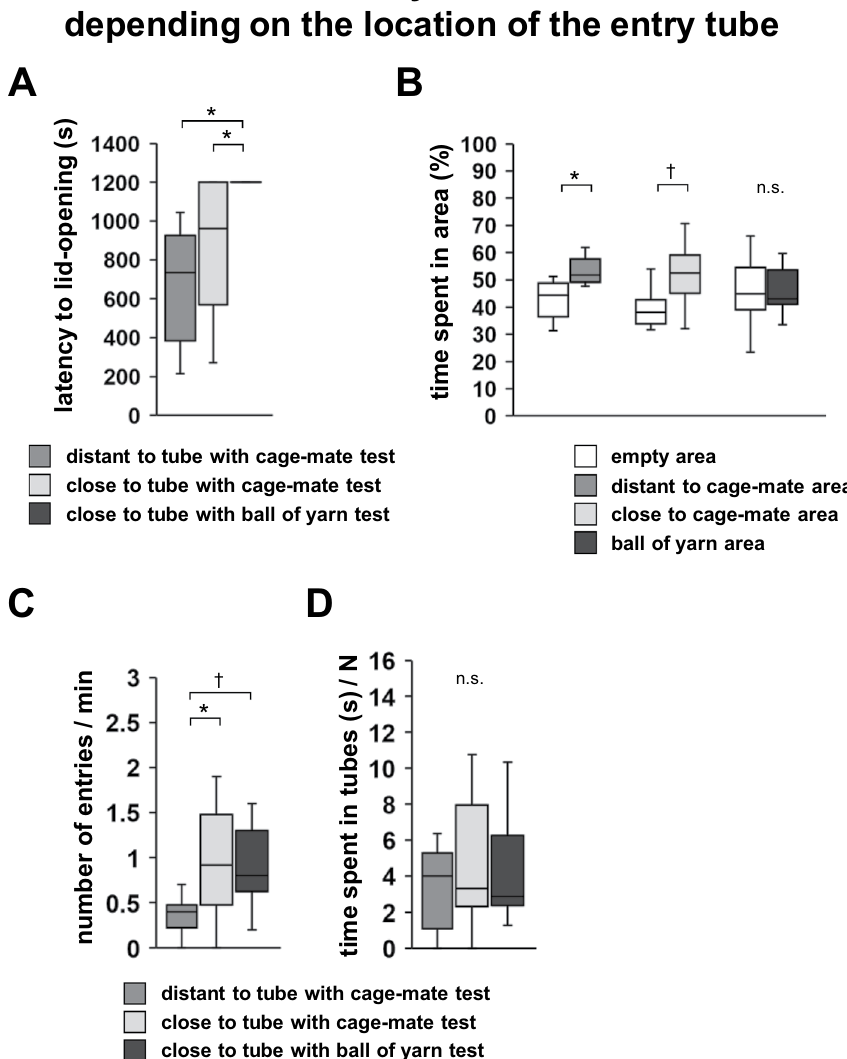
Figure 4. Tube entry tests depending on the location of the tube. ( A ) Comparison of the latency to lid-opening in the three tests. ( B ) Comparison of the time spent in each area in the three tests. ( C ) Comparison of the number of entries to the empty tube in the three tests. ( D ) Comparison of the time spent in the empty tubes in the three tests. All data are presented as box plots. Statistical significance is represented as † p < 0.1 and * p < 0.05. n.s., not significant. The p values were calculated by one-way repeated measures ANOVA ( A , C , D ) and paired t- test ( B ). n = 10 animals per